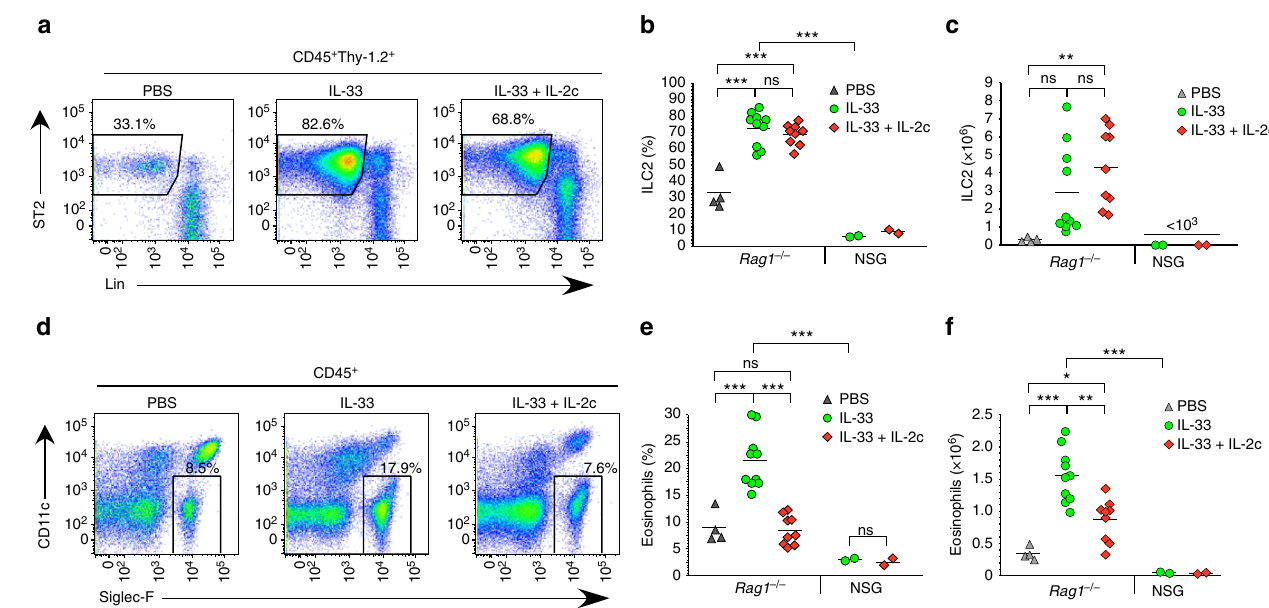
Fig. 7 In vivo generation of ILC2 10 is associated with reduced eosinophil recruitment. a Rag1 − / − mice were injected with the indicated cytokines for four consecutive days and analyzed for lung ILC2 the following day. b , c Compiled data of ILC2 frequency ( b ) and numbers ( c ) from Rag1 − / − or NSG mice treated as in a . d Rag1 − / − mice treated as in a analyzed for lung eosinophils. e , f Compiled data of eosinophil frequency ( e ) and numbers ( f ) from Rag1 − / − or NSG mice treated as in d . Data are from one (NSG) or four ( Rag1 − / − ) independent experiments with representative plots shown in a , d and compiled data on individual mice shown in b , c , e , f . *** P < 0.001, ** P < 0.01, * P < 0.05 and ns (not signi fi cant, P > 0.05) (Student ’ s t